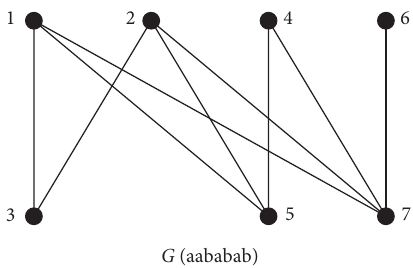
Figure 1: The PWRG of the word